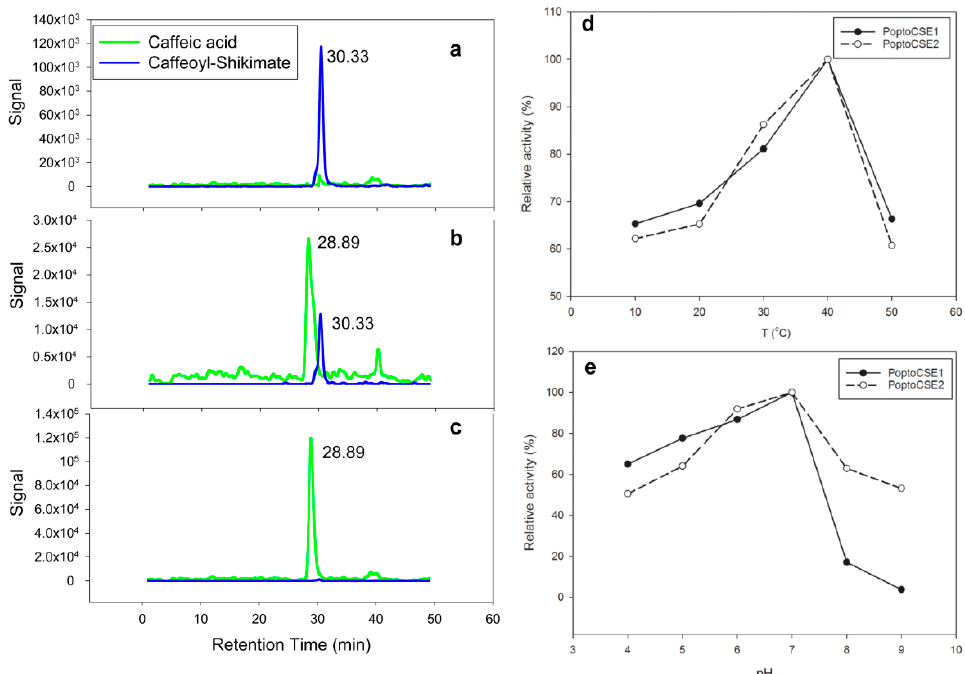
Figure 7. Enzymatic assay of PoptoCSE1 and PoptoCSE2. ( a – c ) The decrease in caffeoyl shikimate and the increase in caffeic acid along with the reaction process catalyzed by PoptoCSE1 with different reaction times: 5 s ( a ), 80 s ( b ) and 120 s ( c ). ( d , e ) The temperature ( d ) and pH ( e ) profiles for recombinant PoptoCSE1 and PoptoCSE2 activities. The mean value of three replicates was used to calculate the relative activity.